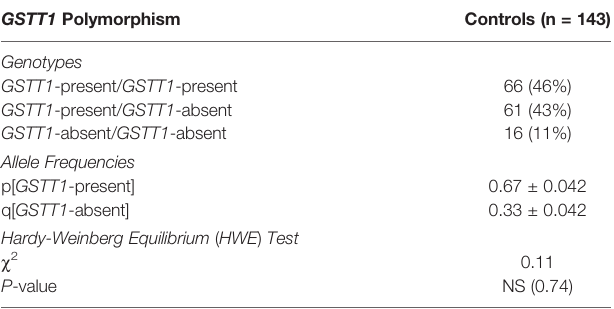
TABLE 2 | Distribution of GSTT1 genotypes and allele frequencies (with standard errors) in age- and gender-matched controls. Assessment of HWE test in controls.